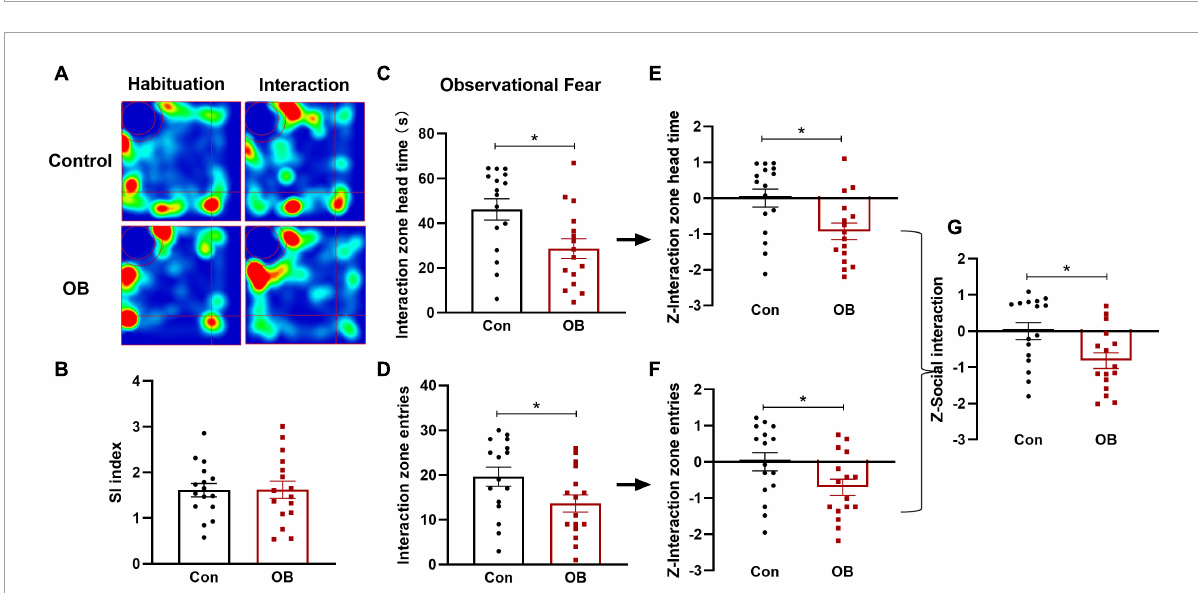
FIGURE4 Social behavior and emotionality Z -scores in social interaction (SI). (A) Representative locomotor path of mice in the two groups in habituation and interaction stage. (B) No significant difference in the social index between the two groups during the first two stages. The social index is calculated as: time spent with the DM mouse during interaction/time spent with the empty cup during habituation. (C,D) Head time and entries in the interaction zone of the model group were both lower than that of the control during the observational fear stage. (E,F) Normalization of Z -score for the two parameters with the same statistical P -values. (G) Z-SI calculated by averaging Z -scores of the two SI parameters showed a significant difference between the two groups. Data are expressed as mean ± SEM ( n = 16) and compared by unpaired t -test. * p < 0.05.